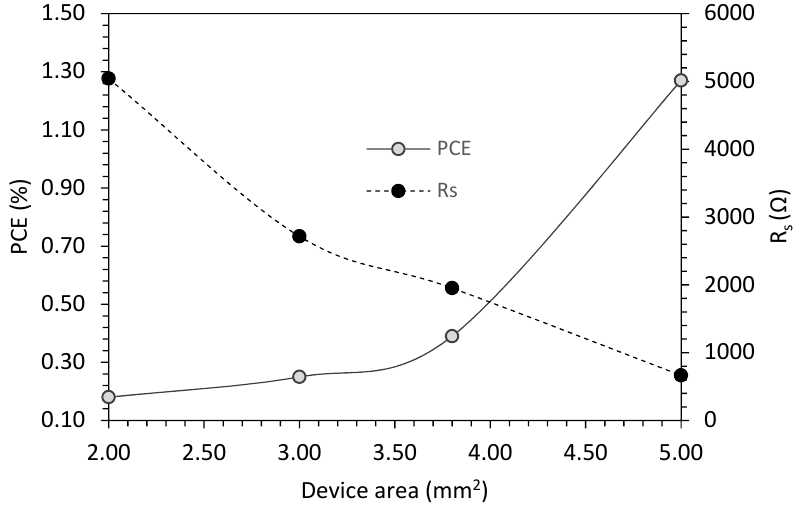
Figure 8. J-V characterisation of OPV based on graphene electrode when illuminated under the full area and the mask area.